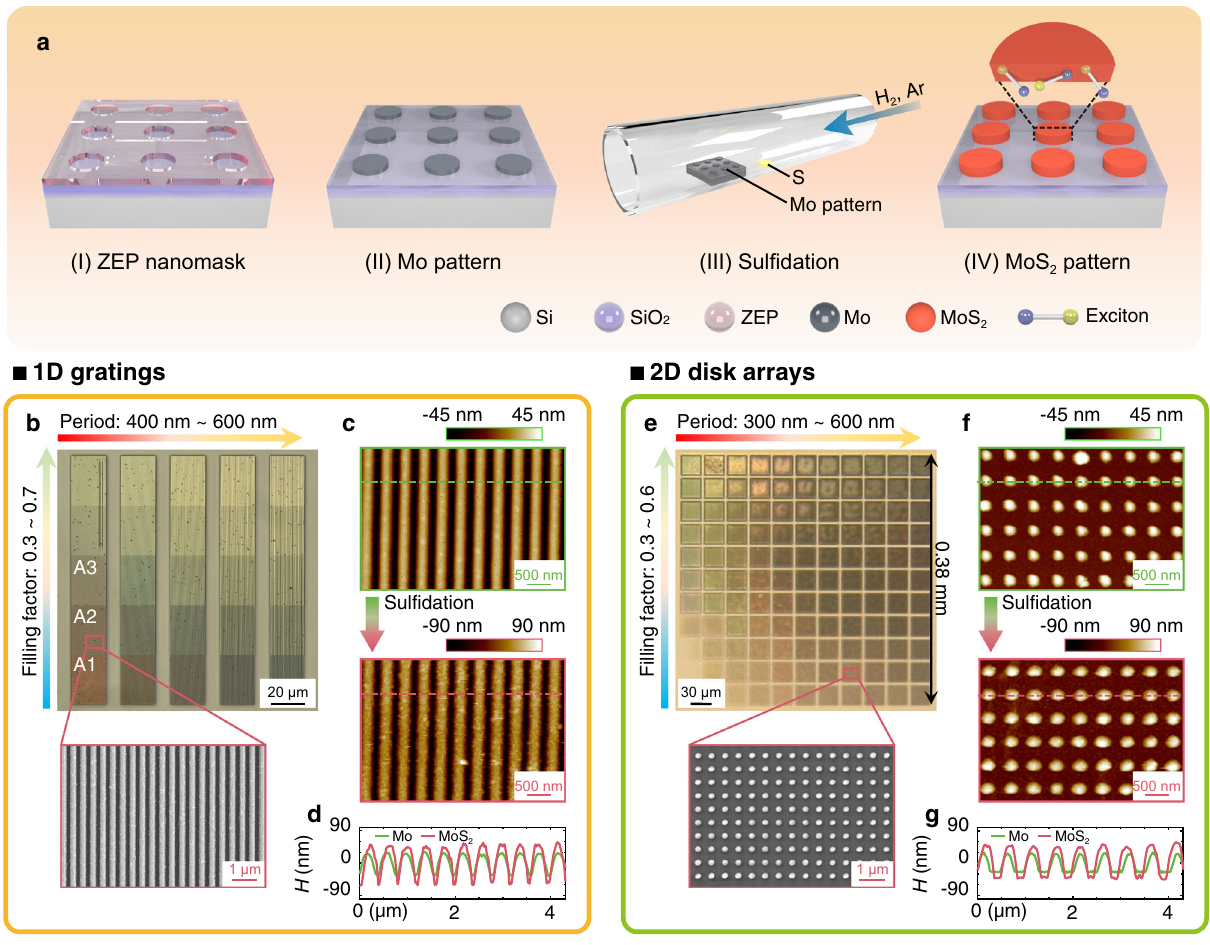
Λ (from 0.3 to 0.7 with a step of 0.1). A zoomed-in scanning electron microscopy (SEM) image for A2 region is shown at the bottom. c Atomic force microscopy (AFM) images of Mo pattern and MoS 2 pattern (A2 region). d Height pro fi les contrast of Mo pattern (green line) and MoS 2 pattern (red line) indicated by the dashed lines in ( c ). e – g Same as ( b – d ) but for the 2D MoS 2 disk